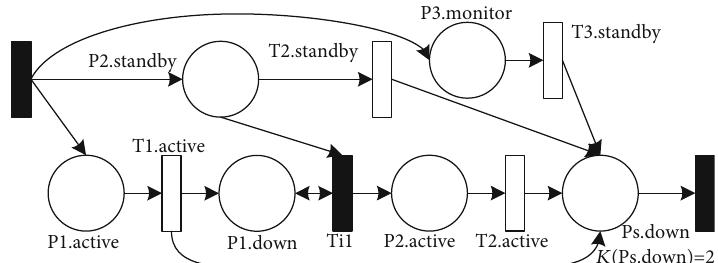
Figure 11: Petri net-based reliability model of the fl ight-control-computer subsystem.